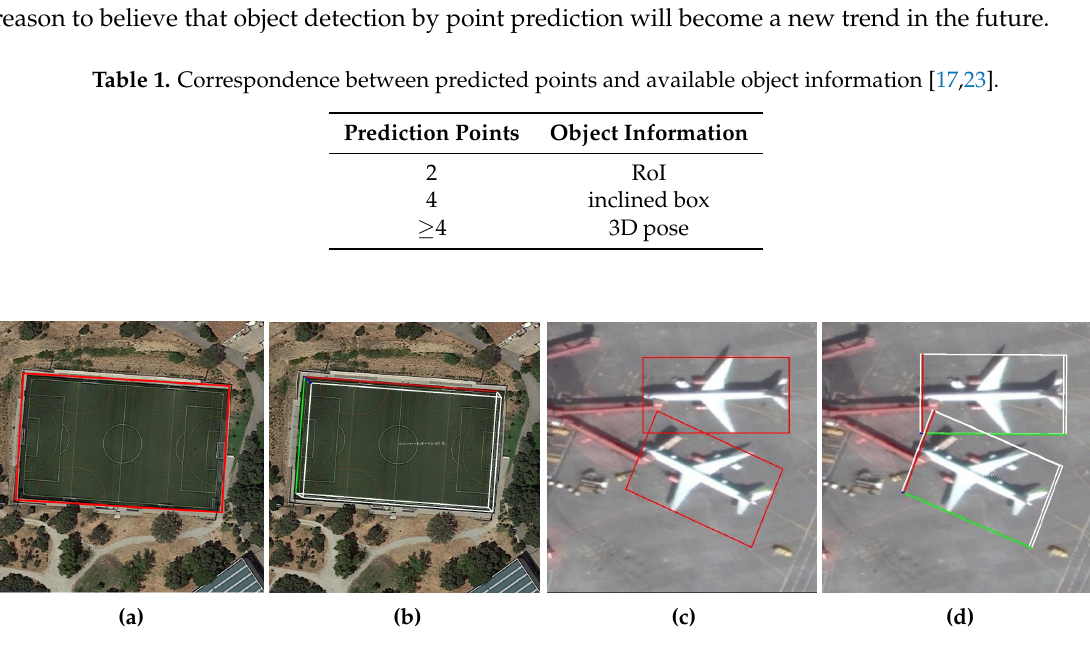
Figure 1. Object detection comparison. ( a , c ) Traditional inclined box. The inclined box has symmetry, so it is not possible to uniquely describe the direction of the object in the 2D image space, so the object has four possible directions. ( b , d ) The 3D pose diagram obtained from APP. The X-axis of the object is marked with red, the Y-axis is marked with green, and the Z-axis is marked with blue. The X-axis points to the right side of the object; the negative direction of Y-axis indicates the static direction of the object; and the Z-axis points to the